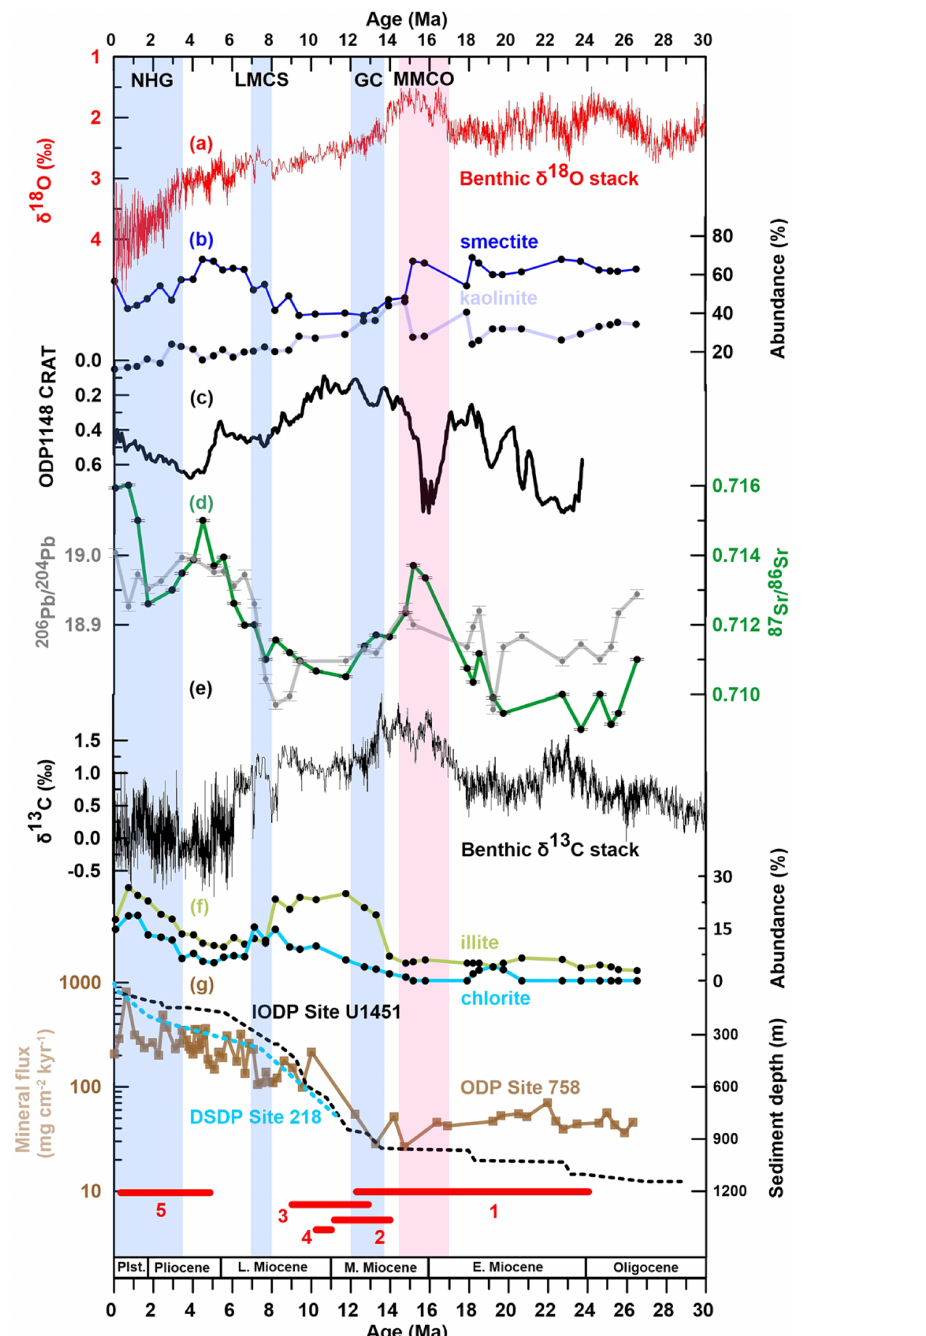
Figure 4. (a, e) Global δ 18 O and δ 13 C from bottom-living (benthic) foraminifera compiled from more than 40 DSDP and ODP sites (Zachos et al., 2008) representing global ice volume and deep-sea temperature, highlighting the global climate changes of the last 30Myr. Periods of global cooling, after Zachos et al. (2008), are marked with blue bars, and the MMCO is marked with a red bar (b, f) . Clay mineralogy of ODP Site 758, relative abundances (% of smectite and kaolinite, illite, and chlorite), I CRAT record of ODP Site 1148 (Clift et al., 2008) from the South China Sea as a record of East Asian monsoon development, (e) Nd and Pb isotope composition of ODP Site 758 clays, (g) mineral flux record (Hovan and Rea, 1992) of ODP Site 758 recalculated using updated linear sedimentation rates, and sedimentation rates from the Bengal fan DSDP Site 218 and IODP Site U1451 (France-Lanord et al., 2016; Galy et al., 2010), and at the bottom a summary of the regional tectonic events (Allen and Armstrong, 2012). 1 – high Himalayan uplift, Main Central Thrust (MCT); 2 – onset of normal fault, southern Tibet; 3 – surface uplift, eastern Tibet; 4 – initial thrusting on main boundary Thrust; and 5 – fast exhumation at Himalayan syntaxes, outward growth of NE Tibet. This figure is from Ali et al.